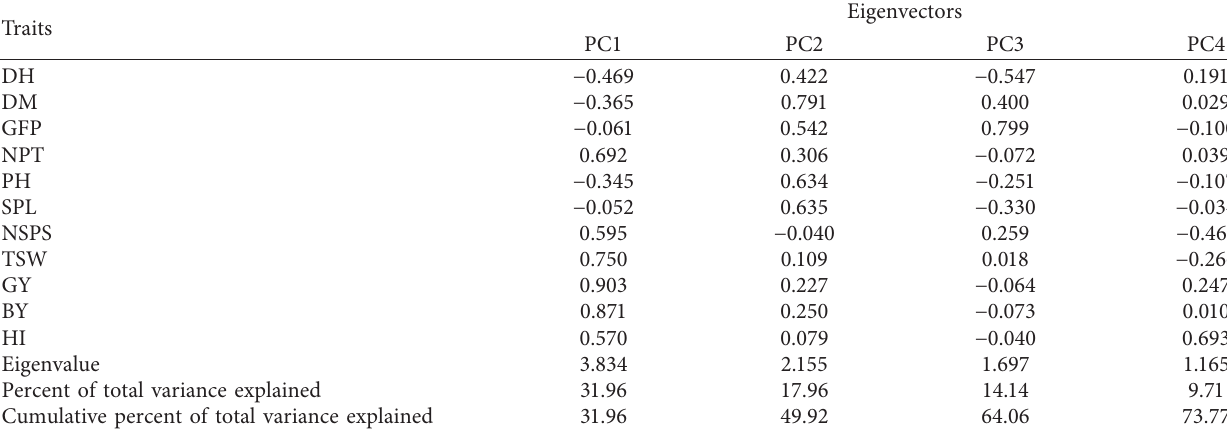
Table 4: Eigenvectors and eigenvalues of four principal components (PCs) for eleven quantitative traits of bread wheat germplasms. Traits